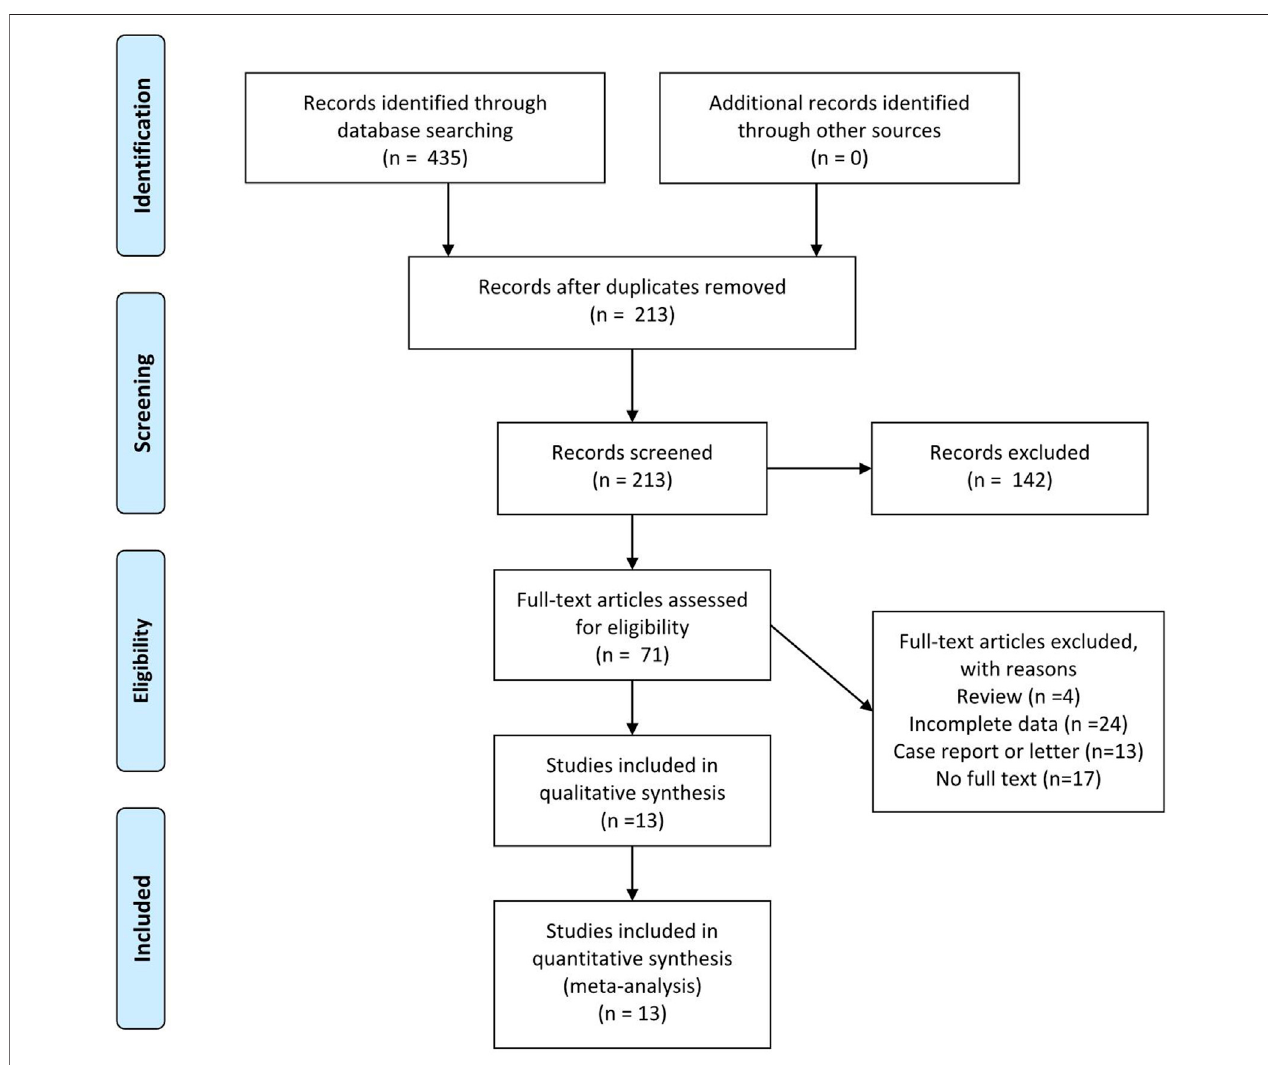
FIGURE 1 | Preferred reporting items for systematic review and meta-analysis (PRISMA) fl ow